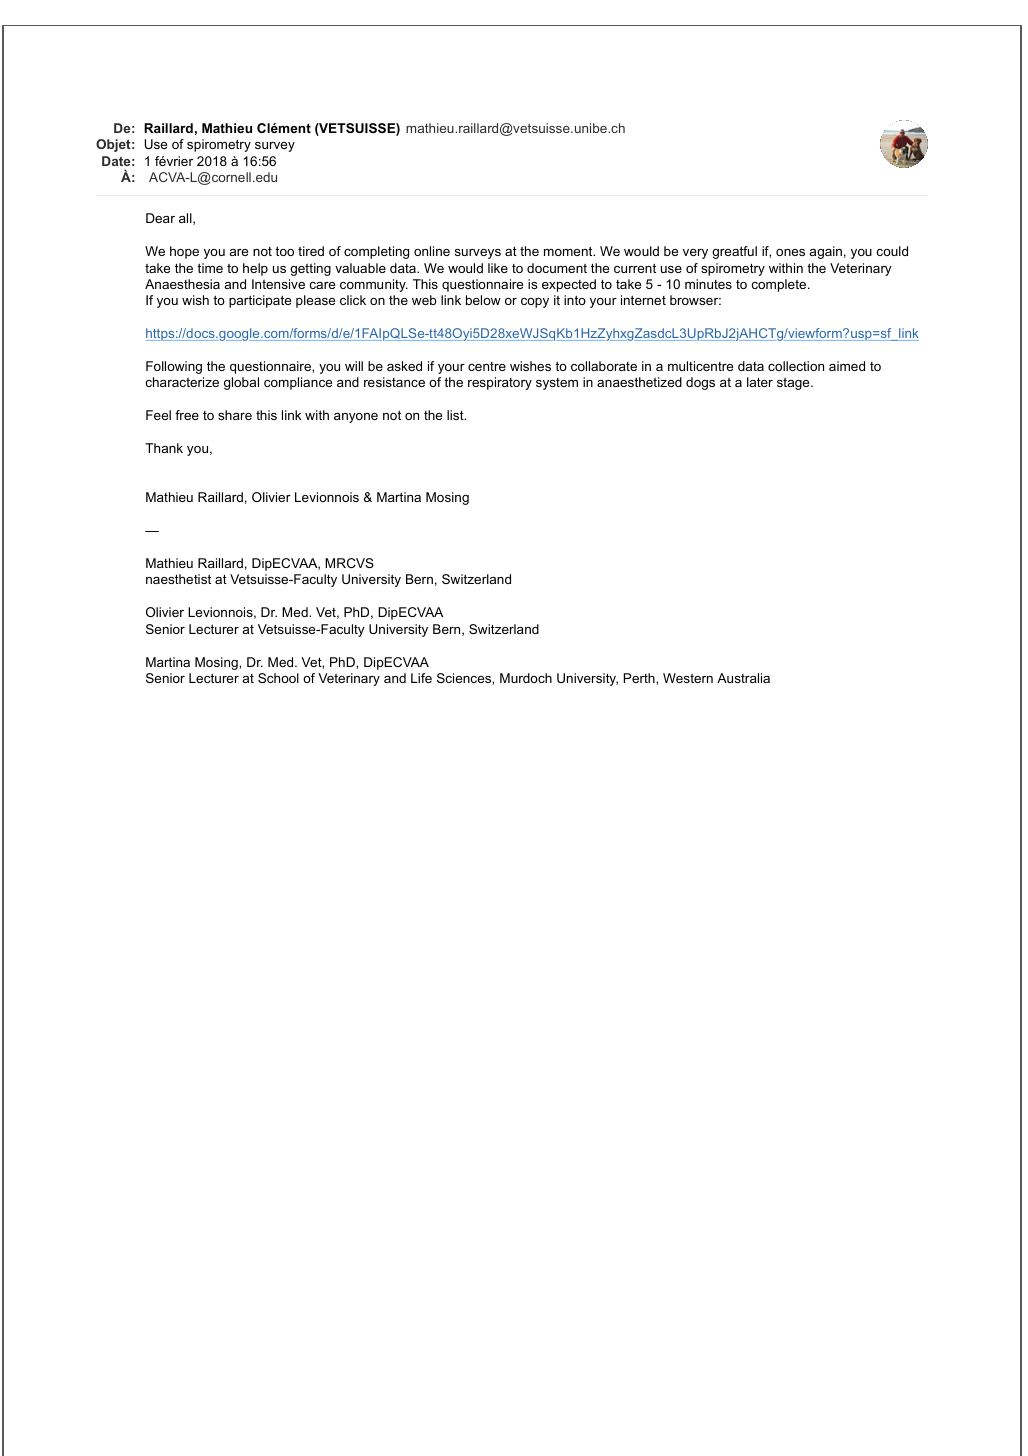
Figure A7. Example of survey announcement on the ACVA-L.